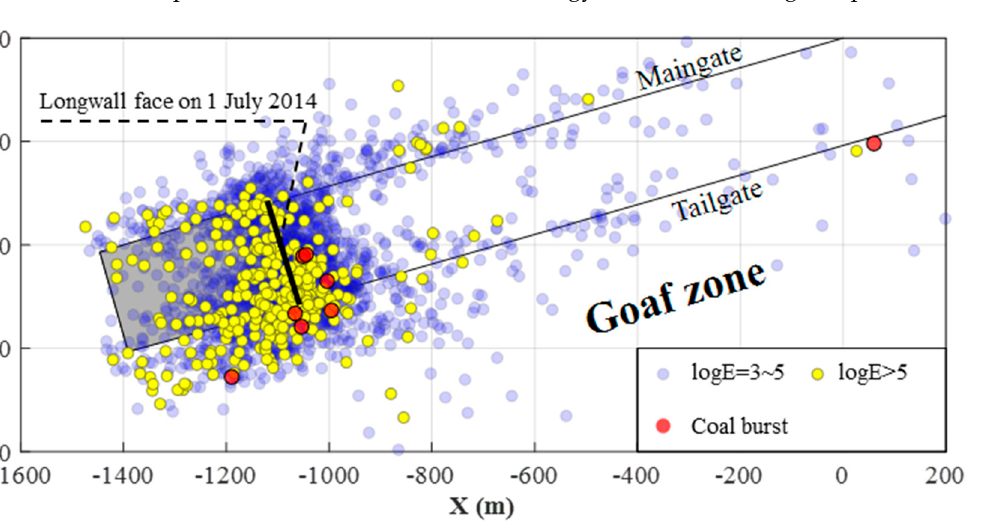
6 of 18 Figure 2. LW250105 layout and geophone distribution in roadways. The location of Geophone #2 was modified on 5 June 2014. 3.2. Seismic Monitoring System and Seismic Hazards Before the retreat of LW250105, Huating coal mine installed an “SOS” seismic mon- itoring system from the Central Mining Institute of Poland. The system is equipped with 16 uniaxial geophones, including six in the LW250105 roadways and ten in excavations far away from the longwall. The geophones have a response of 1–600Hz, a sampling rate of 500Hz, a maximum data transmitting rate of 1 MB/s, and a 16-bit A/D conversion. In this study, seismic events that occurred from 5 April 2014 to 1 July 2014 in LW250105 were used for the analysis. During the study period, Geophones #1, #2, #7, #13, and #16 were available to monitor the seismic activities of the longwall. Additionally, Geophone #2 was moved on 5 June 2014 because of the approach of the longwall face, and the layout